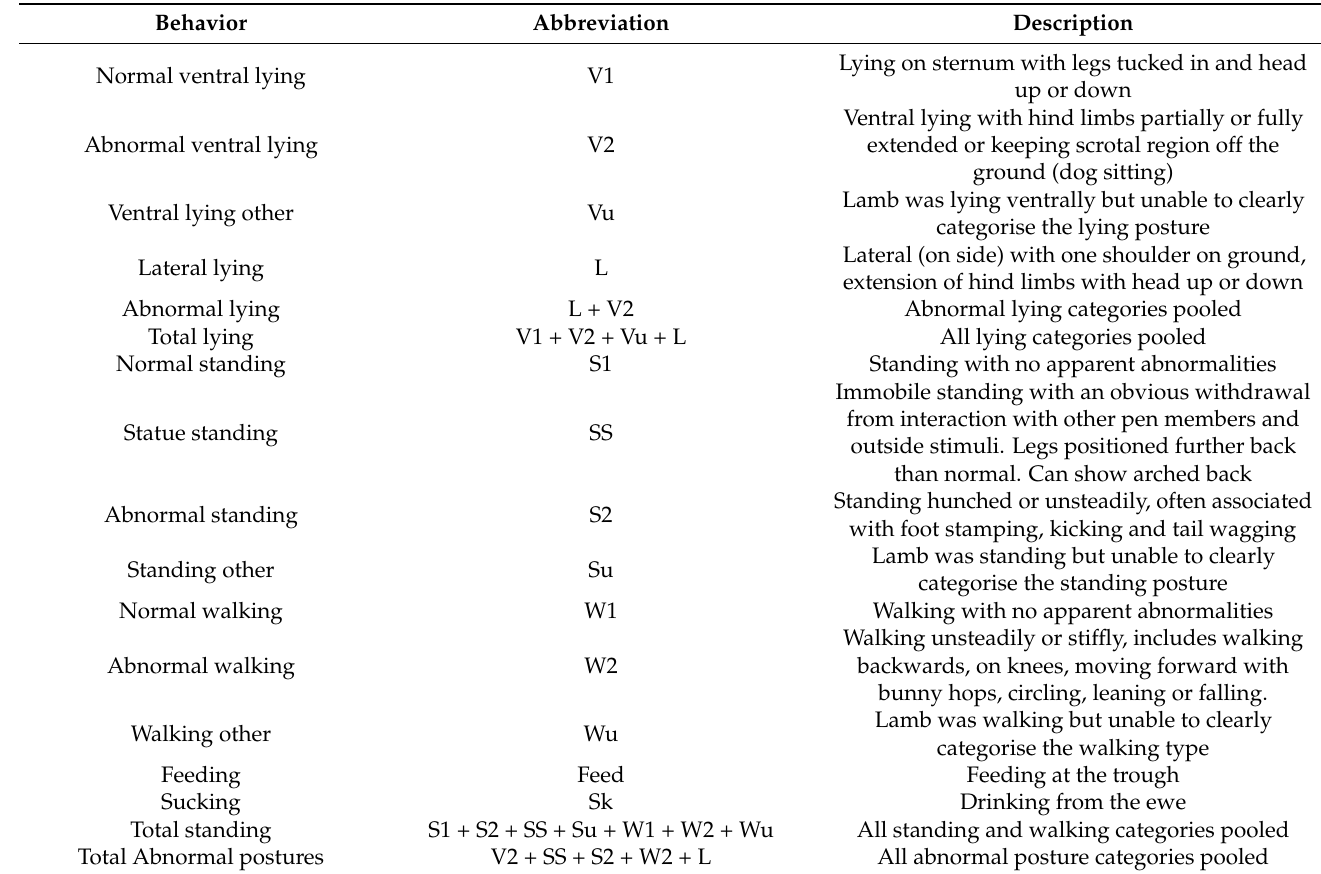
Table 2. Descriptions of postural behaviors recorded during the